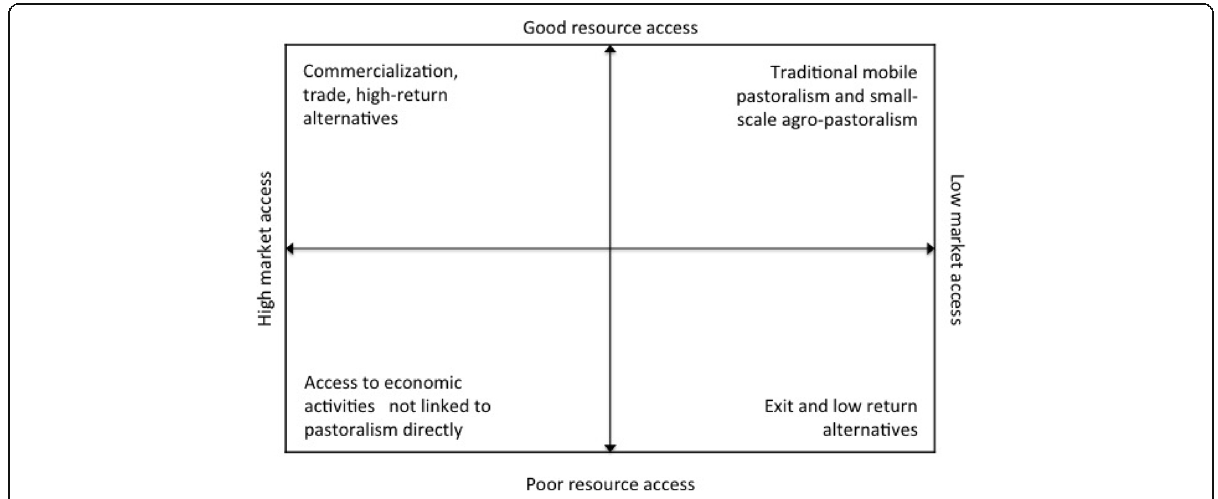
Fig. 2 Livelihood pathways in rangeland Eastern